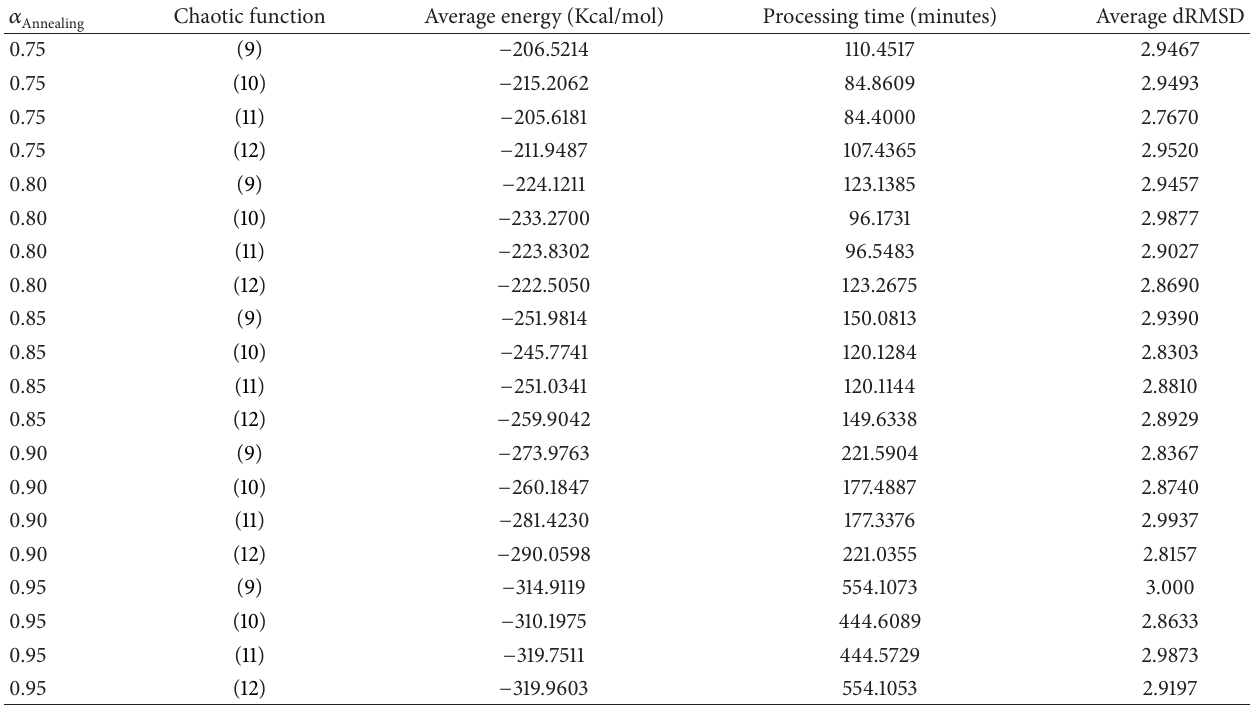
Table 6: Average results of T0281 instance.